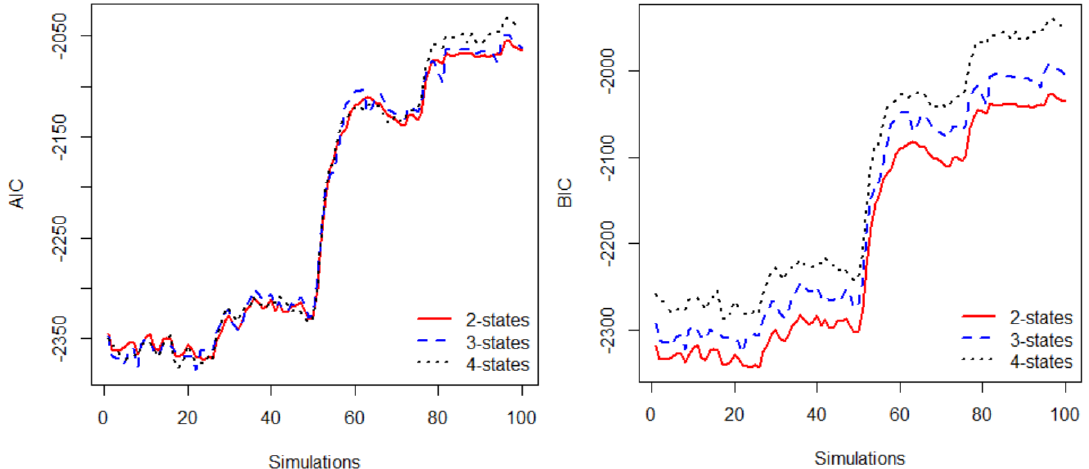
Figure 5. AIC ( left ) and BIC ( right ) for 100 parameter calibrations of HMM using Facebook, FB, stock daily return